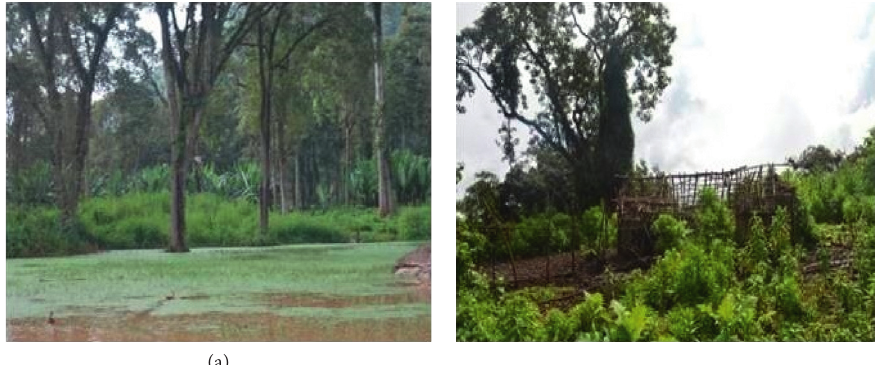
Figure 3: The modified MAF habitat at Nensebo forest, Southern Ethiopia (photo: Zerubabel Worku,